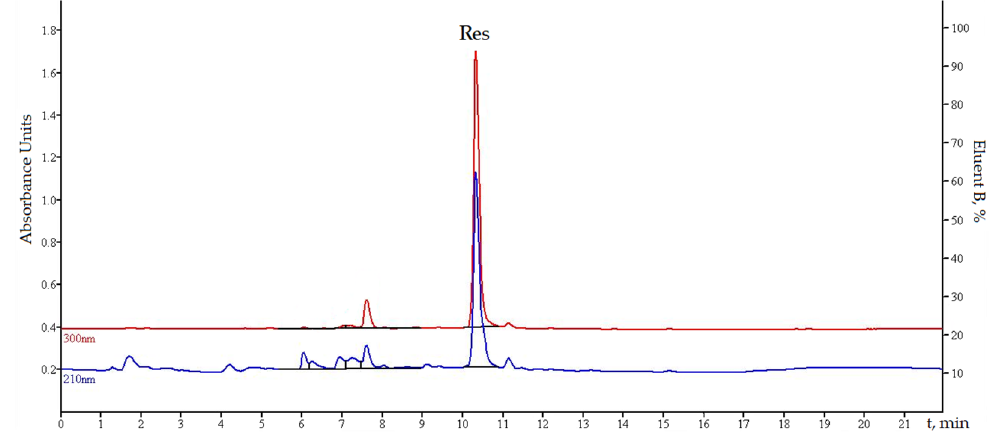
Figure 4. Chromatogram of resveratrol extract from wheat straw matrix.